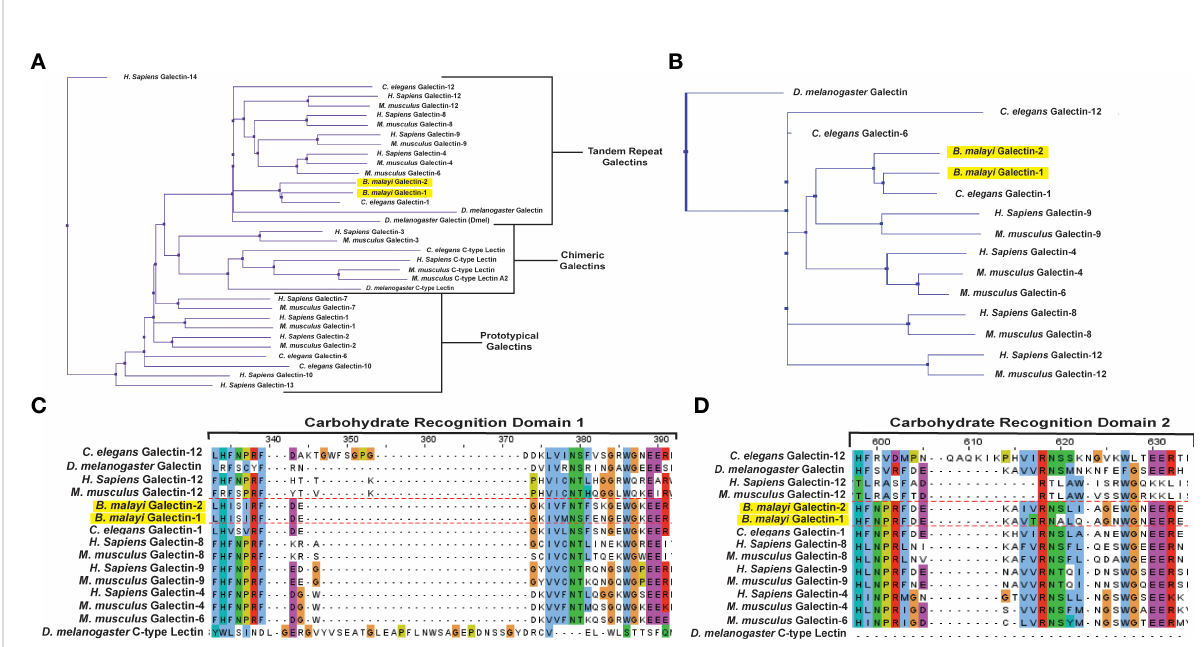
FIGURE 2 Bma-LEC-1 and -2 are similar to other tandem-repeat type galectins. (A) Bma-LEC-1 and Bma-LEC-2 cluster with other tandem-repeat type galectins from diverse species. (B) Within the tandem-repeat galectins compared, Bma-LEC-1 and Bma-LEC-2 are most closely related to C. elegans LEC-1 and human/mouse galectin-9. Multiple sequence alignment of carbohydrate recognition domain 1 (C) and carbohydrate recognition domain 2 (D) characteristic of tandem-repeat type galectins revealed that Bma-LEC-1 had 83% identity to Celegans LEC-1 and 60% identity to human/mouse galectin-9, while Bma-LEC-2 had 71% identity to C. elegans LEC-1 and 59% and 58% identity to human/mouse galectin-9, respectively. Jalview (version 2.11.1.4) was used to create phylogenetic trees and multiple sequence alignment fi